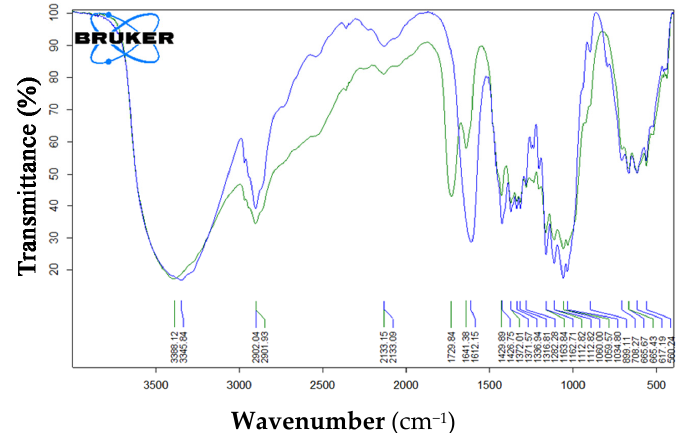
Figure 2. FT-IR analysis of ONC in the acid form.